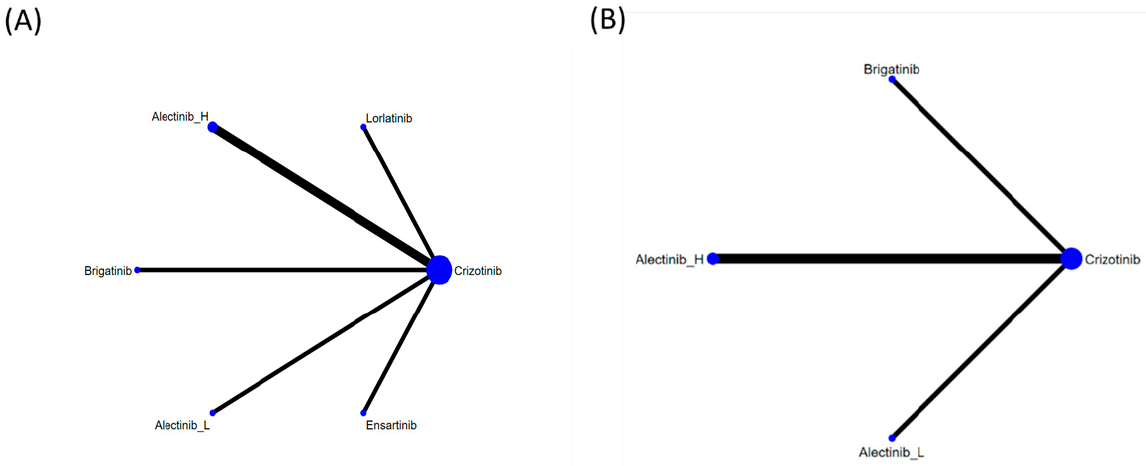
Figure 2. Network constructions for comparisons in PFS and ORR: ( A ) network constructions for PFS, ( B ) network constructions for ORR.